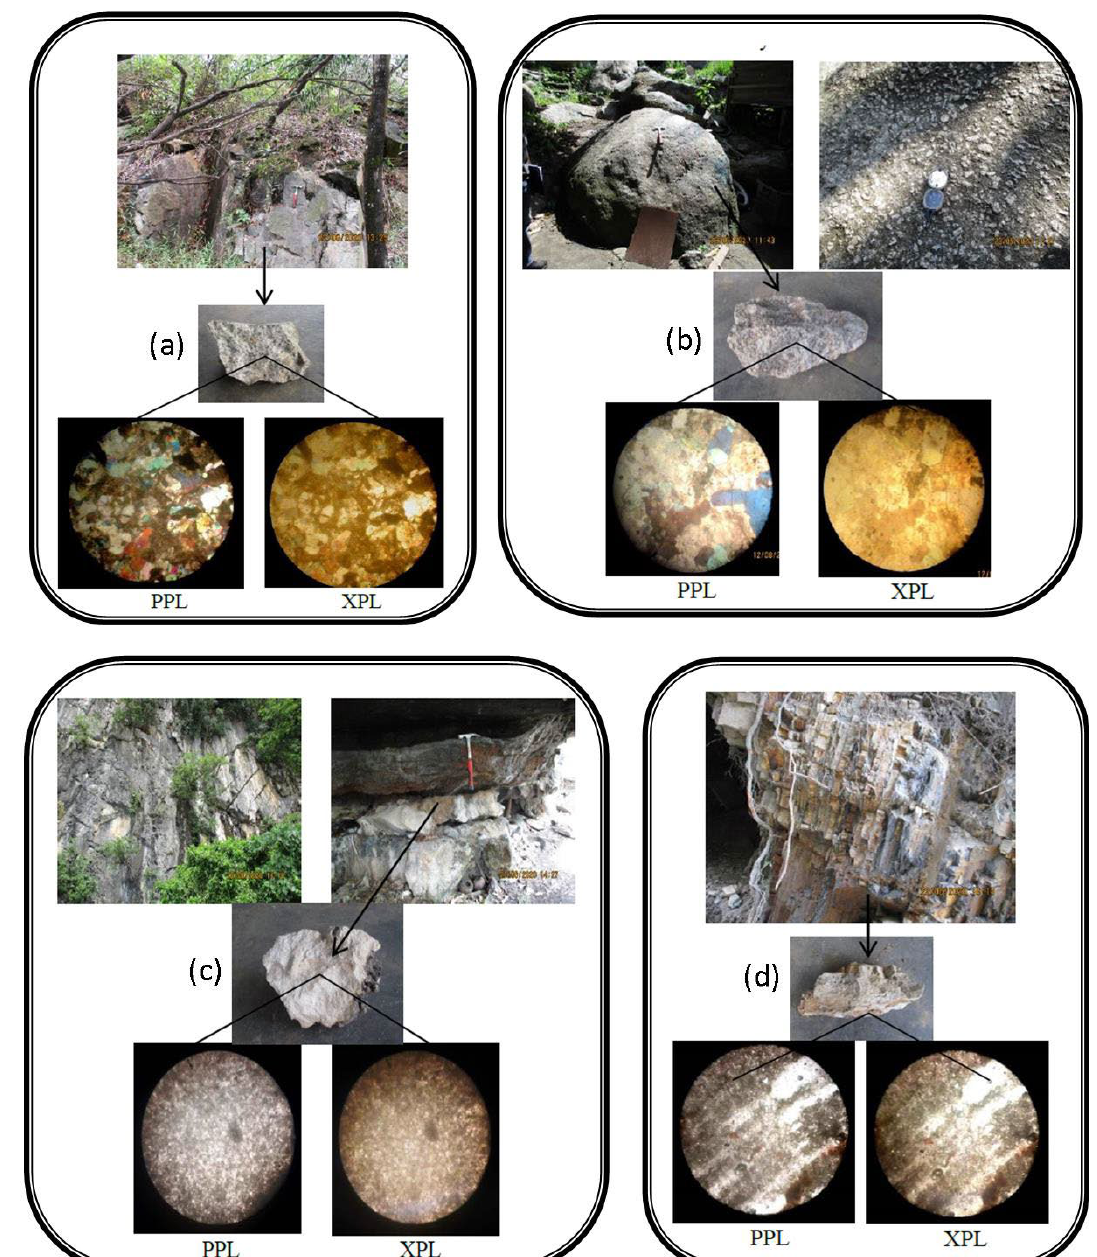
Figure 7: Petrograhy of Lithologies along Taiping to Ipoh Segment of the Highway showing outcrop exposures, hand specimens and thin sections in PPL and XPL of (a) Medium grained granite (b) Porphyritic granite (c) Limestone and (d)